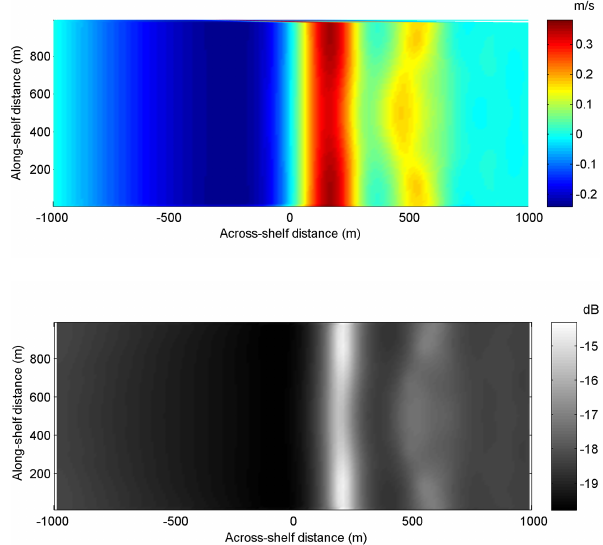
Figure 12. Internal wave signature in velocity field (top) at 1cm depth and radar backscatter intensity map (bottom; NRCS, dB val- ues here should be taken as a relative range). Taken at time t = 2000s.